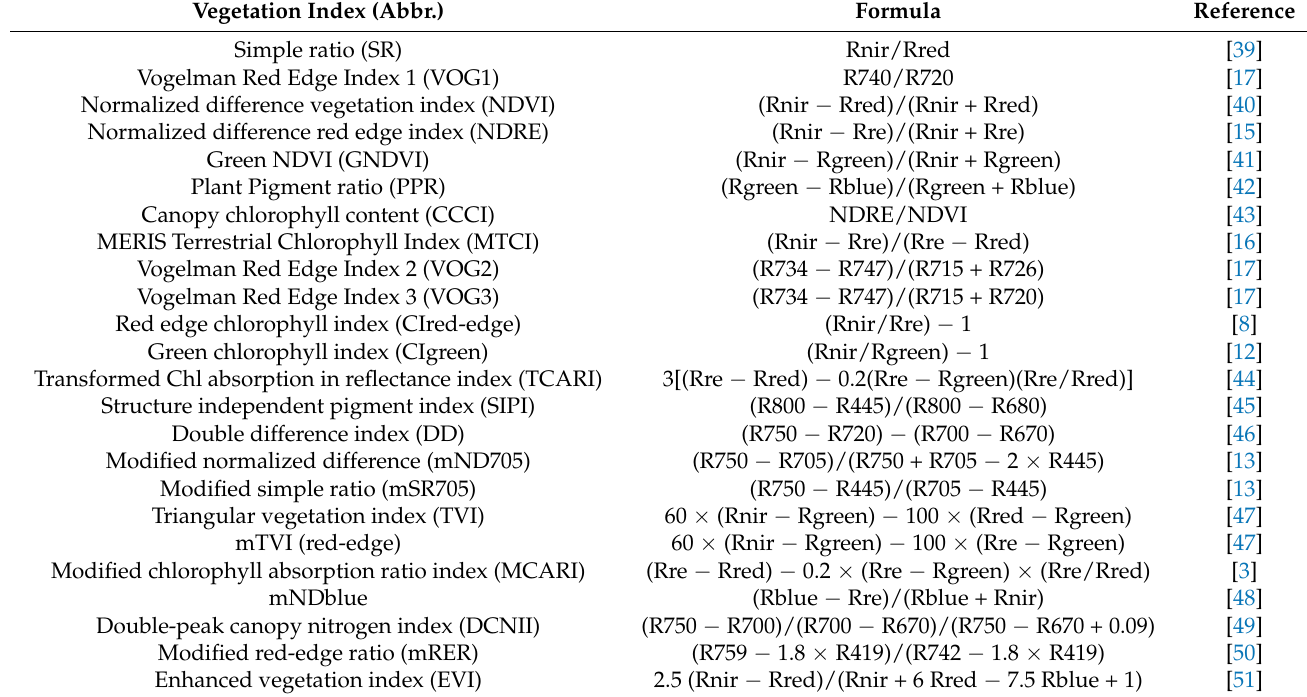
Table 2. Vegetation indices (VIs) studied in this